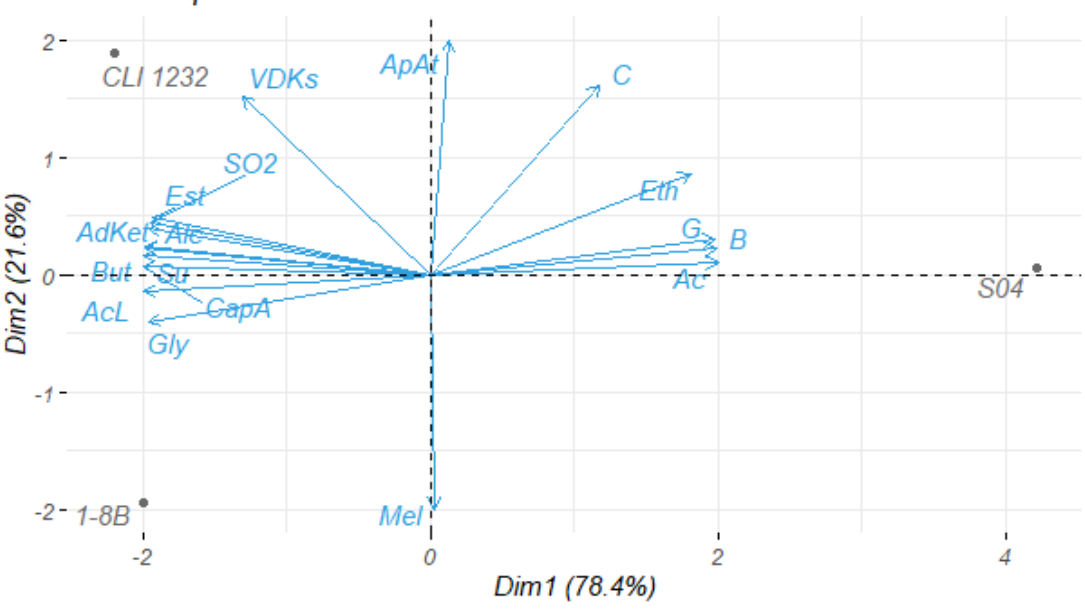
Figure 7. Projection of the 100 L beers on the axes formed by the principal components 1 and 2. Each object is the average of the three corresponding experimental beers. Eth, ethanol; Gly, glycerol; ApAt, apparent attenuation; AcL, lactic acid; C, colour; B, bitterness; SO 2 , dioxide sulphide; VDKs, vicinal diketones; Su, residual sugars; Alc, total higher alcohols; Est, total esters; Ac, total fatty acids; AdKet, total aldehydes/ketones; But, γ -butyrolactone; G, guaiacol; Mel, melatonin; CapA, antioxidant capacity.